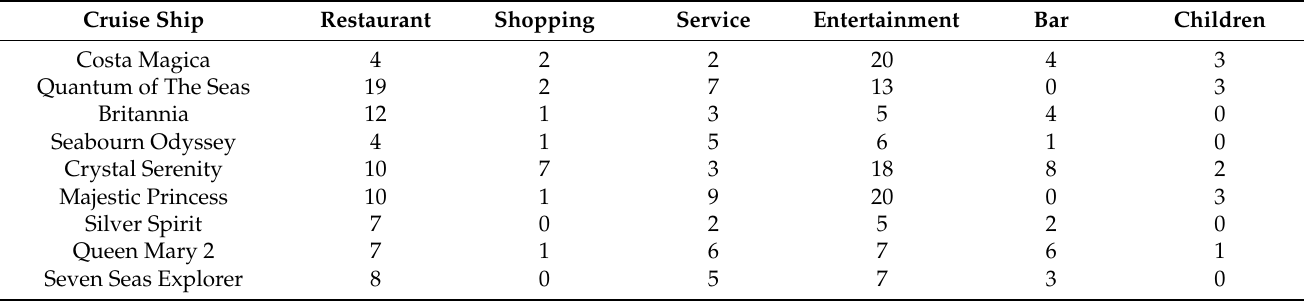
Table 7. The service facilities of cruise ships.